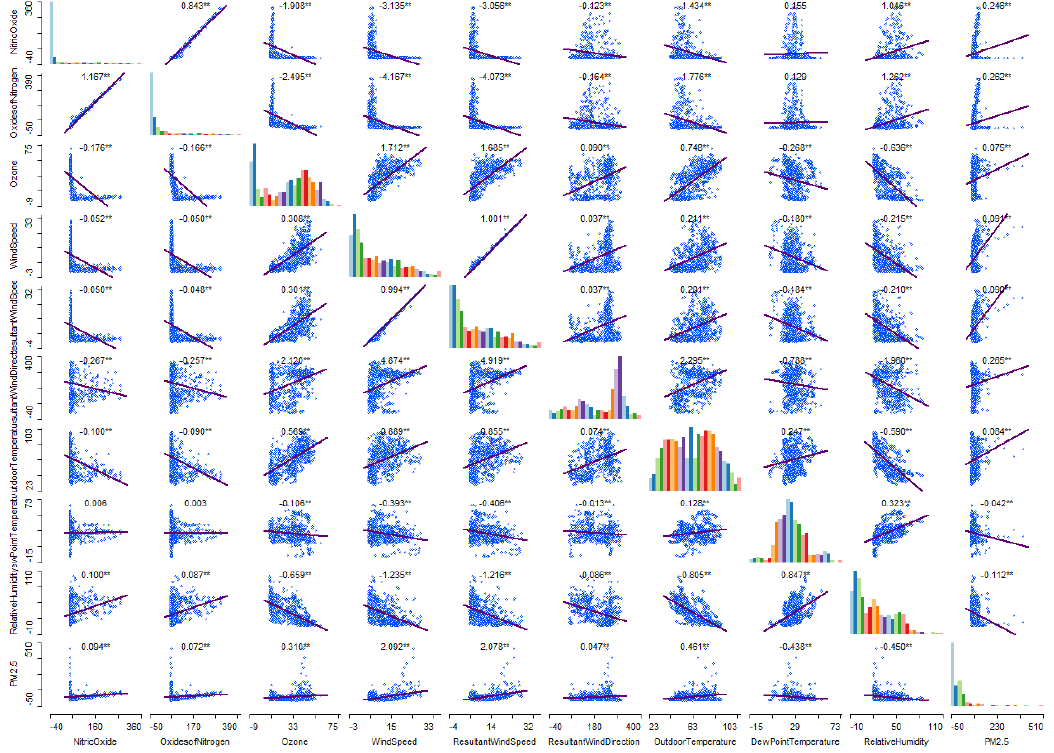
Figure 6. Scatter plots with the slope